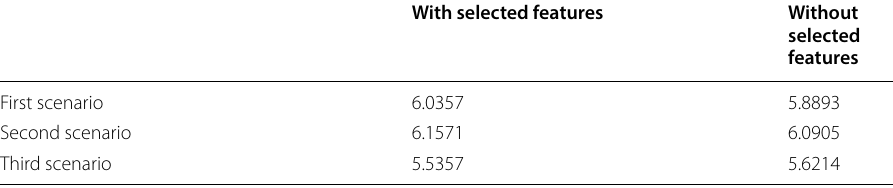
With selected features Without